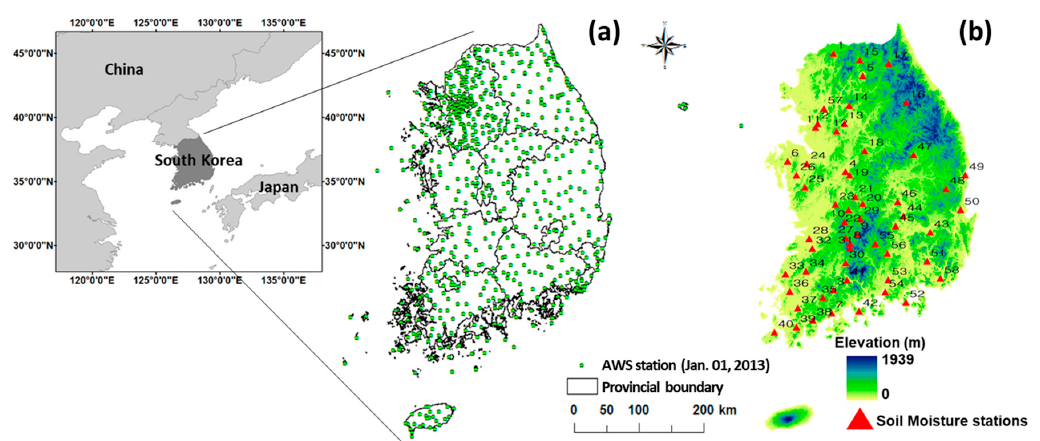
Figure 2. Observation stations: ( a ) the 687 automatic weather stations (AWS) and ( b ) the 58 soil moisture stations run by various institutions with elevation.